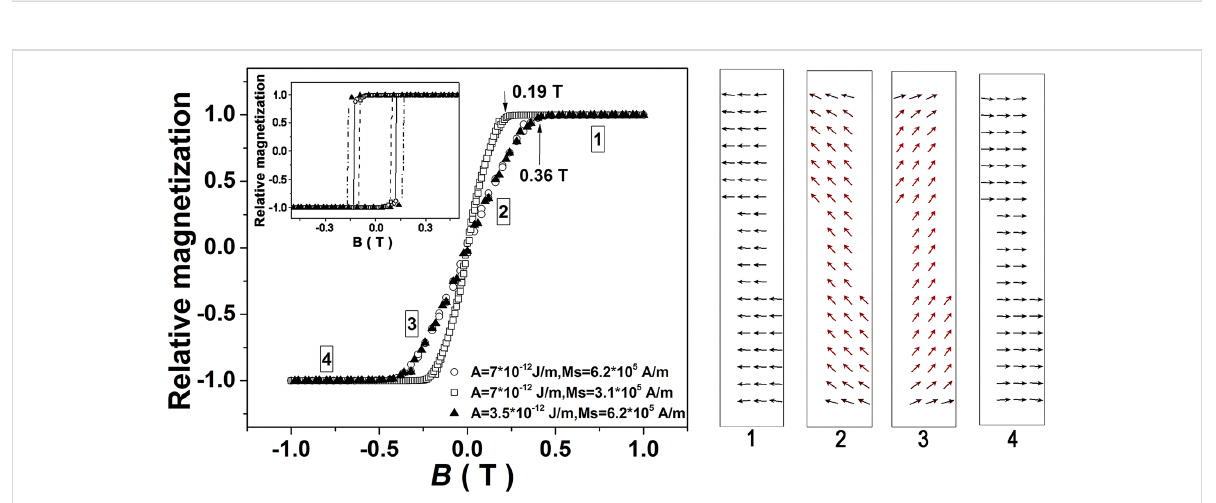
Figure 5: Magnetization reversal in almost perpendicular geometry at two different values of saturation magnetization and stiffness constant. The cor- responding magnetization reversals in almost parallel geometry are shown in the inset. A deviation of the wire axis from the orthogonal axis of about 10° was considered. The evolution of the spin structure at four different decreasing field values is graphically presented on the right-hand side of the figure (the positive field is oriented almost perpendicular to the wire toward the left side).